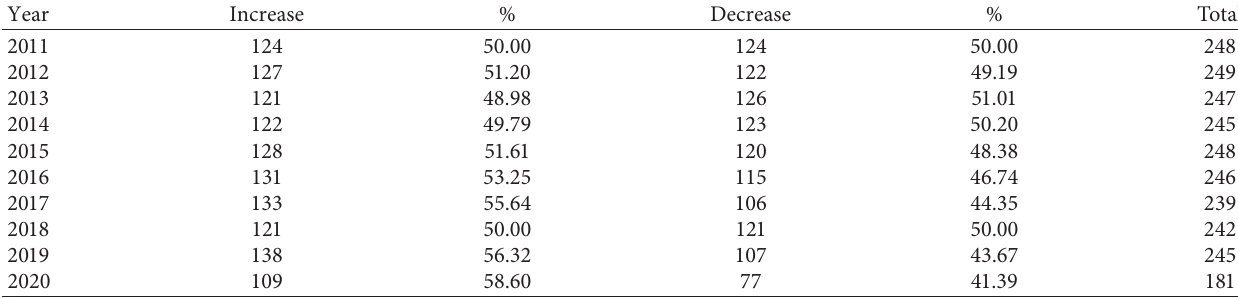
Table 7: Percentage of increase and decrease cases of KOSPI.